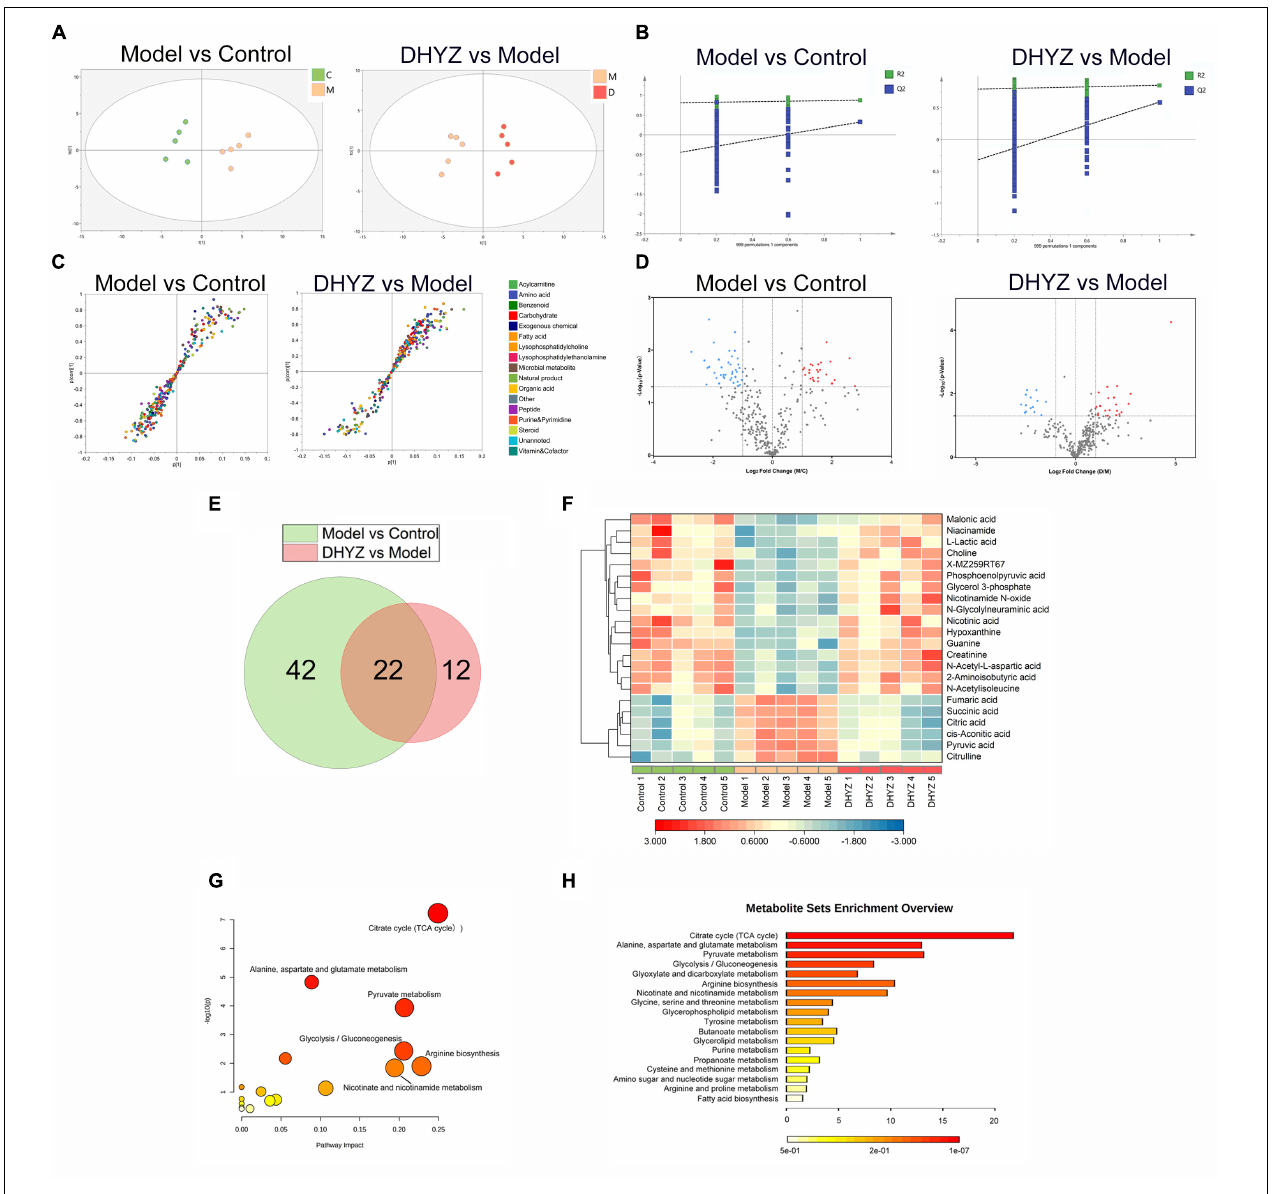
FIGURE 5 | Untargeted metabonomics profiling of AD treatment by DHYZ. (A) Score plot of PCA modeling to maximize inter-group differentiation of metabolomics data between the model and control group and between DHYZ and model group. (B) 999 times permutation to test the robustness of OPLS-DA modeling between model and control group and between DHYZ and model group. (C) S-plot of OPLS-DA model differentiating the model vs. control group and the DHYZ vs. mode group. (D) Volcano plot to visualize differential metabolites of significance between the model and control group and between the DHYZ and model group. (E) Venn diagrams of potential metabolites between the model and control group, and between the DHYZ and model group. (F) The heat map of potential metabolites involved in 2 × Tg-AD mice treated by DHYZ. MetaboAnalyst analysis and visualization of metabolism pathway involved in treating AD with DHYZ. (G) Summary of pathway analysis visualized by the dot chart. The dots represent the pathways that were matched pathway impact values from pathway topology analysis and p -values from pathway enrichment analysis. (H) KEGG enrichment analysis of metabolism pathway for associated urinary metabolites in 2 × Tg-AD mice treated with DHYZ. Metabolites with P < 0.05 and fold change (FC) > 2 were highlighted with red (up-regulated) and blue (down-regulated), respectively. C, control group; M, model group; D, DHYZ group. KEGG, Kyoto Encyclopedia of Genes and Genomes; AD, Alzheimer’s disease; DHYZ,